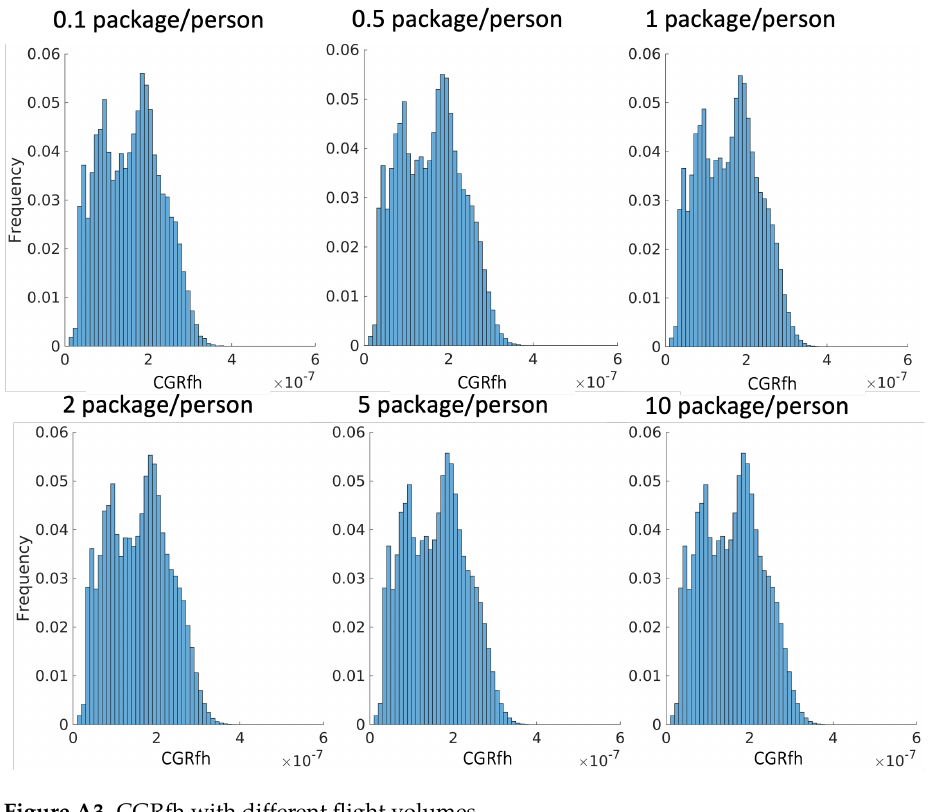
Figure A3. CGRfh with different flight volumes.